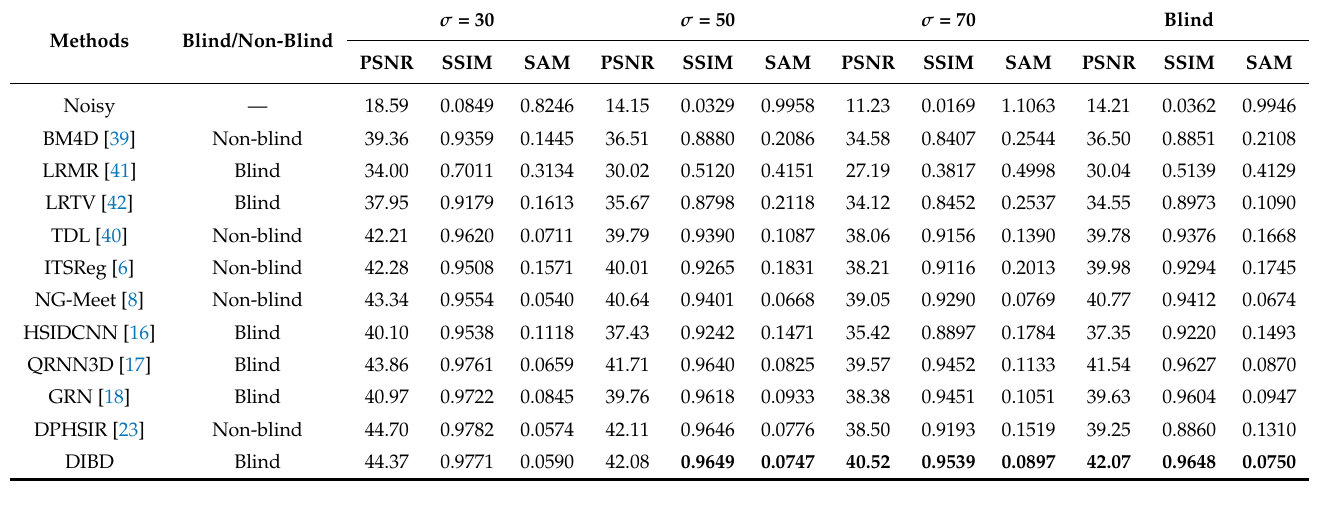
Table 5. Quantitative evaluation of all the competing methods under different Gaussian noise intensities on ICVL dataset.